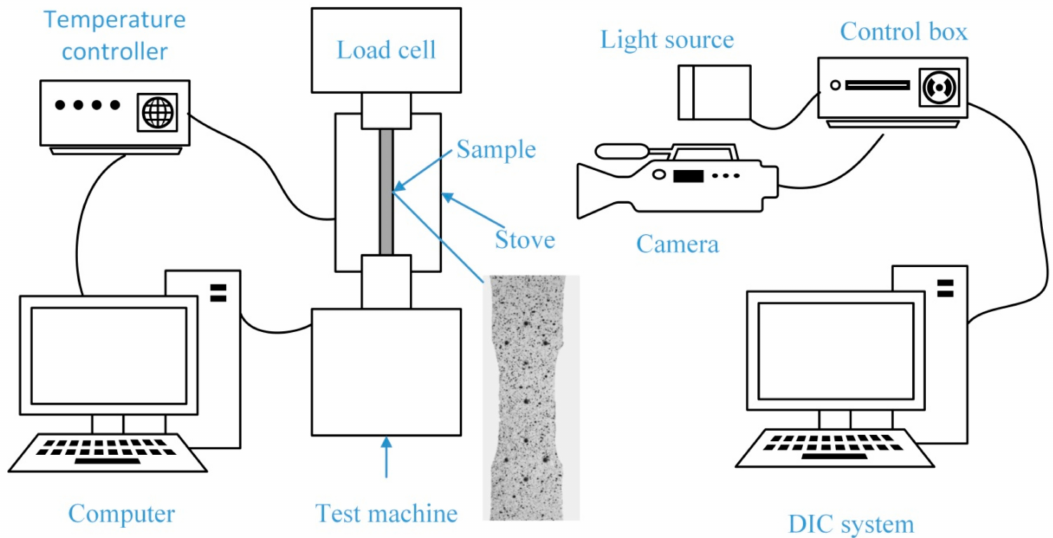
Figure 3. Schematic diagram of the test process and preformed speckle pattern on the surface of the